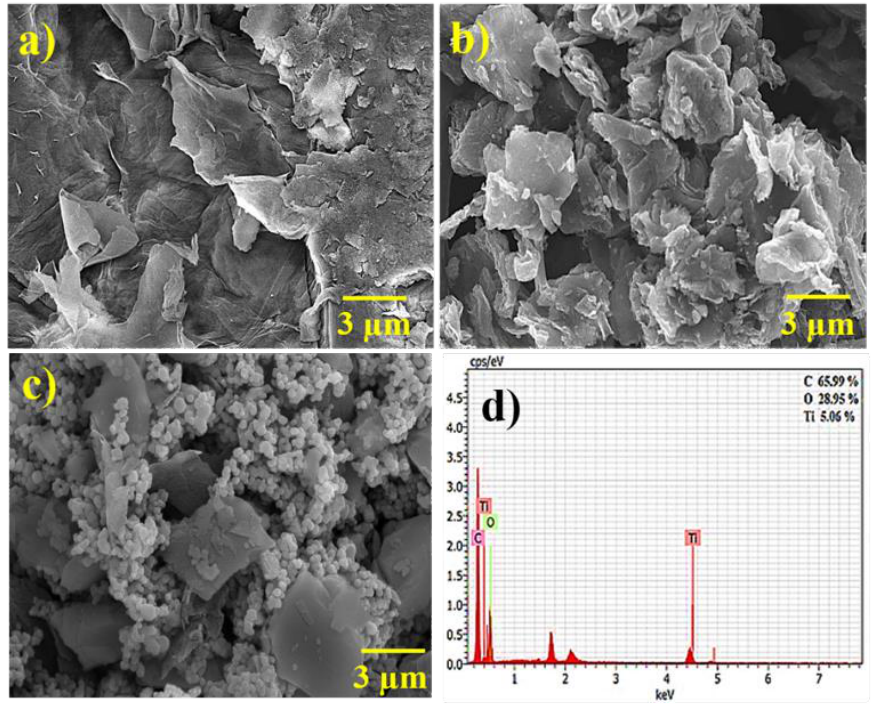
Figure 3. FE-SEM images of; ( a ) GO, ( b ) rGO, ( c ) rGO/TiO 2 , and ( d ) EDS spectrum of rGO/TiO 2 .